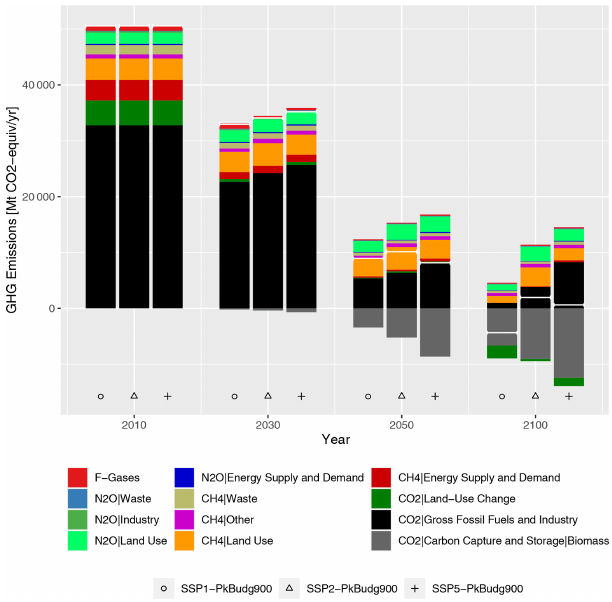
Figure 5. Global GHG emissions by type for the 1.5 ◦ C scenar- ios (pkBudg900) based on SSP1, SSP2, and SSP5. The white line shows net GHG